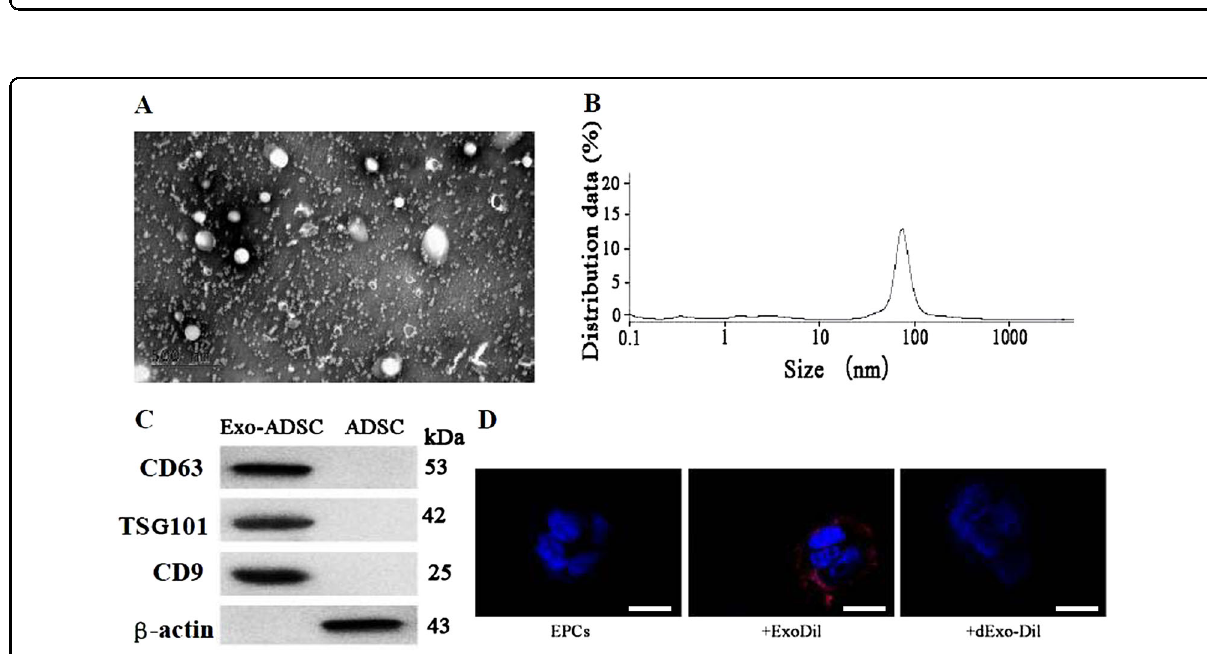
Fig. 5 Isolation and identi fi cation of exosomes from adipose-derived stem cell (ADSC) culture medium. a The ultrastructure of ADSC-derived exosomes by transmission electron microscopy. Scale bar, 100 nm. b Size distribution of Exo-ADSCs determined by dynamic light scattering. c Expression of the exosome markers CD4, CD63, and TSG101 and β -actin con fi rmed by immunoblotting. Exosome lysate was loaded into the left lane and cell lysate into the right. d Representative micrographs of EPCs or EPCs incubated with Dil-labeled Exo ( + ExoDil) or with Dil-labeled EVs denatured by boiling ( + dExo-Dil). Scale bar, 10 μ